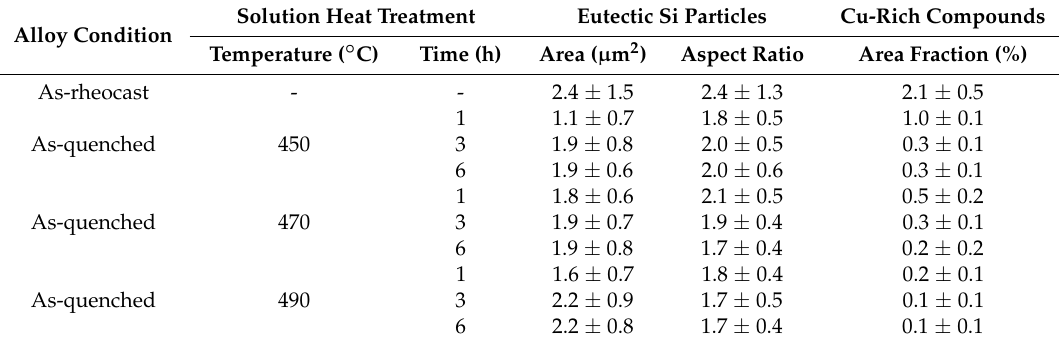
Table 2. Size and morphology of the eutectic Si particles, and area fraction of Cu-rich compounds as a function of the solution heat treatments.